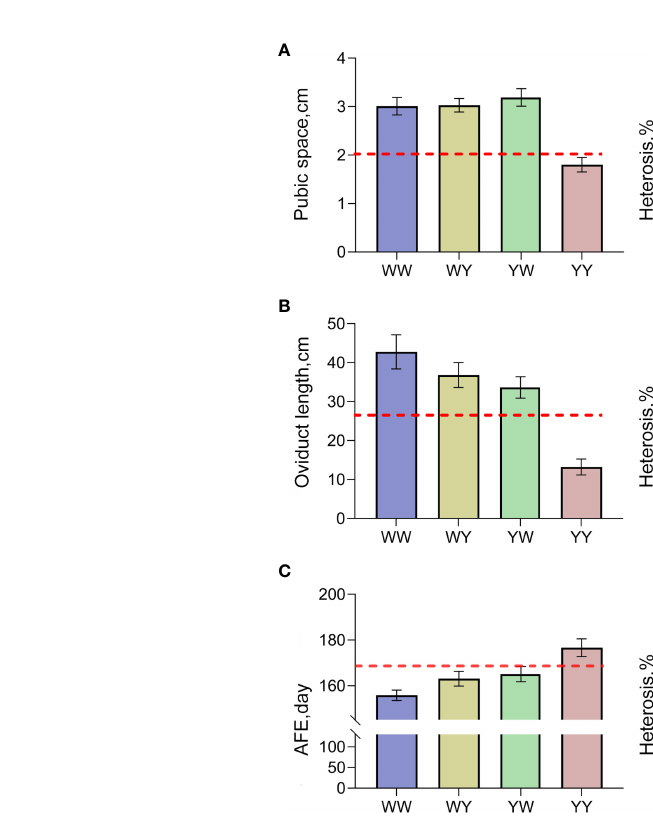
FIGURE 1 | Heterosis of traits related to sexual maturation. (A) Heterosis of pubic space. (B) Heterosis of oviduct length. (C) Heterosis of AFE. The dashed line represents mid parent value. ** indicate that heterosis was highly signi fi cant ( P < 0.01),